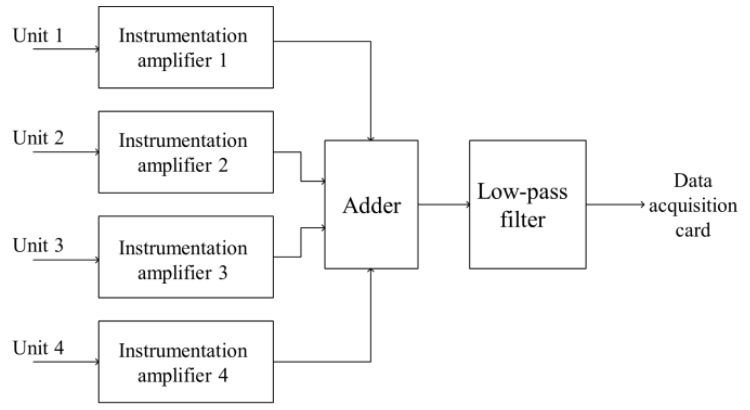
Figure 8. The circuit block diagram of the FUVH